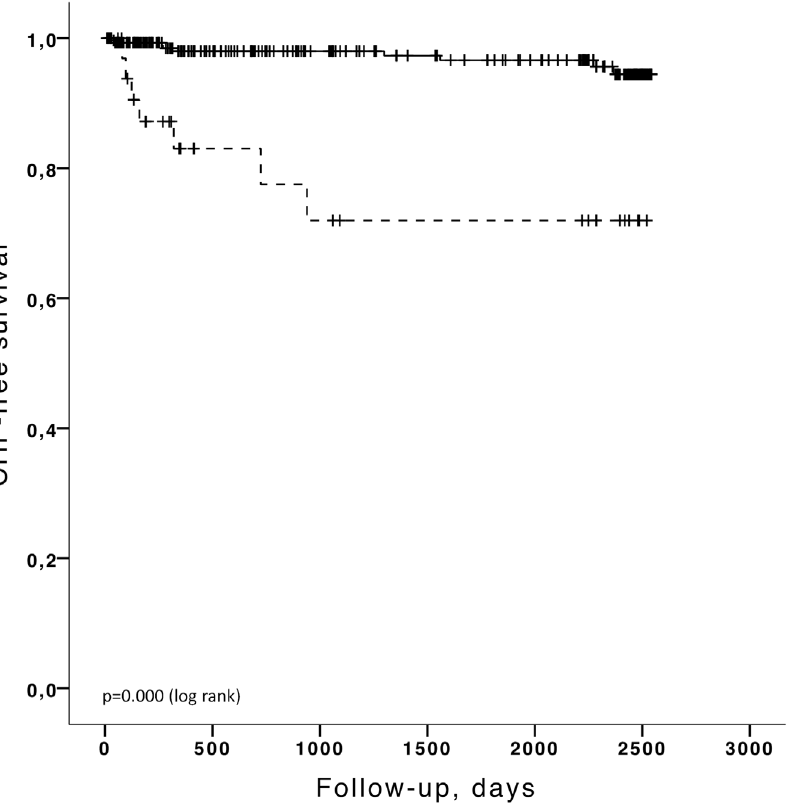
Figure 4. Kaplan-Meier analysis for the probability of CHF hospitalization-free survival according to LVEF above (black, solid) or below 50% (black, solid).